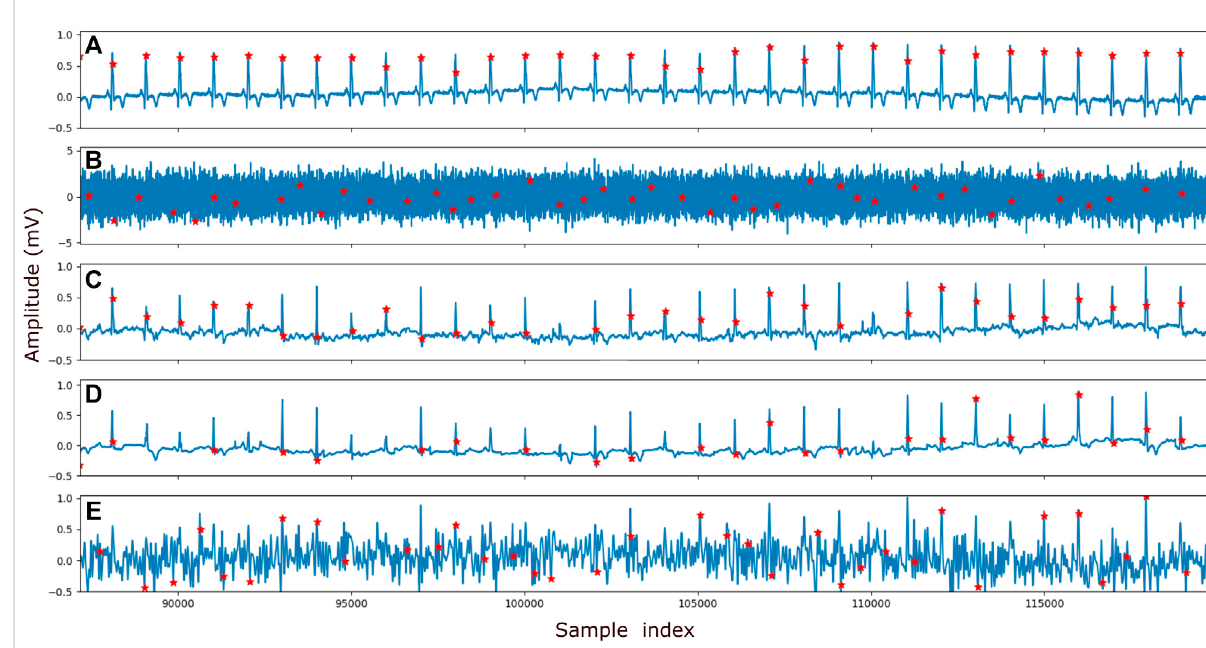
FIGURE 5 Example of the peak detection. In (A) the clean signal, (B) the signal with addded Gaussian noise of SNR − 15 dB (C) the denoised signal by the proposed method, (D) the denoised signal by the reference DAE and (E) the denoised signal by the reference wavelet method is shown. The ECG recording that is visualized here is obtained from patient265, channel 12. Prior to being denoised by our proposed method and the DAE method, the ECG signals are normalized (see Section 2.4). To visualize the output of the method on the same vertical scale as the other ECG signals, the output was corrected for this